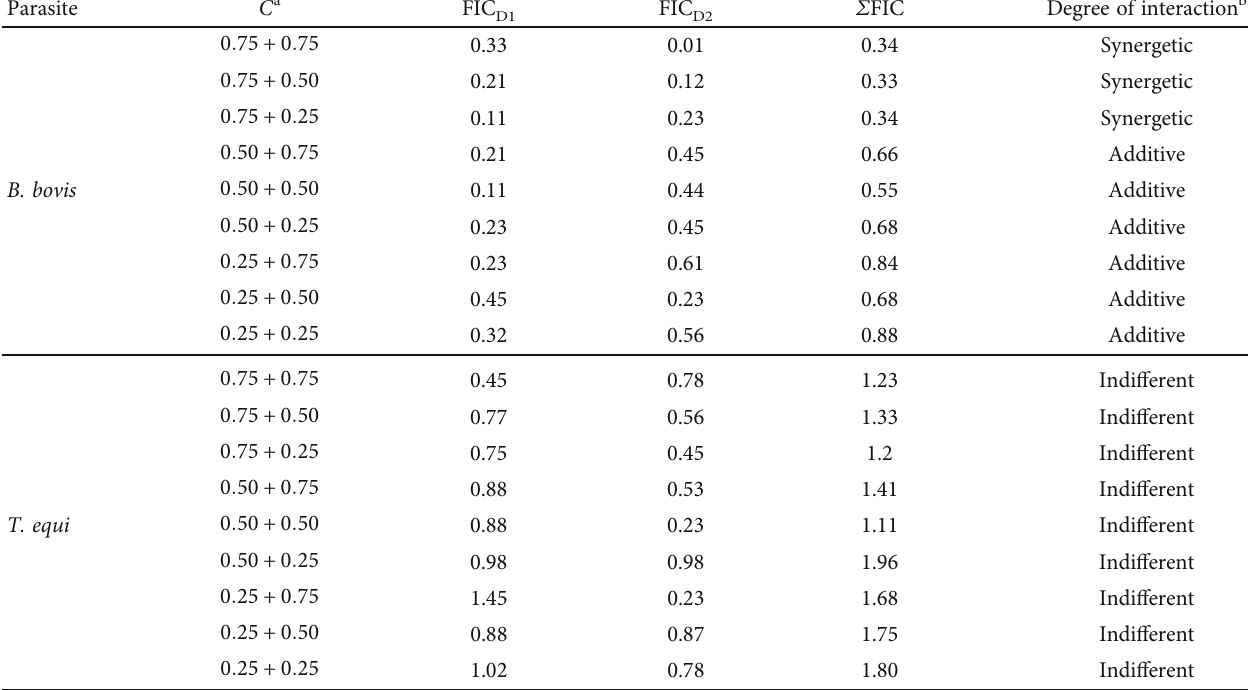
Table 3: Two drug interactions of pomegranate ( Punica granatum ) peel in combination with diminazene aceturate on the in vitro growth of Babesia bovis and Theileria equi parasites.